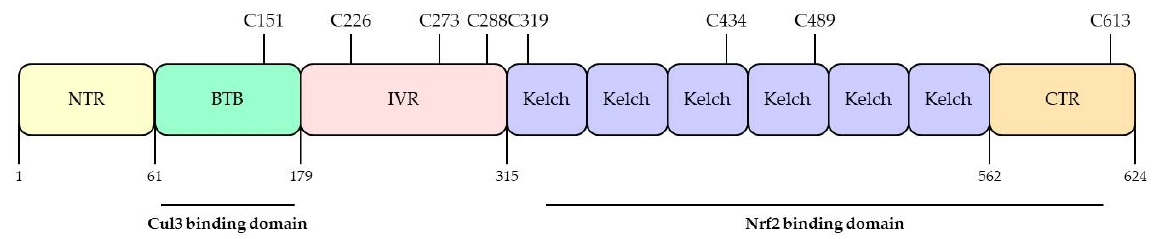
Figure 4. Domain structures and functional domains of KEAP1. The Keap1 protein contains Broad complex/Tramtrack/Bric- a-brac (BTB) domain, the intervening region (IVR) domain, and the Kelch domain. The BTB domain binds to Cul3 and forms homologs and dimers. The IVR domain contains C226, C273, and C288, which regulate Nrf2 activity. The Kelch domain has 6 conserved Kelch repeat sequences in the C-terminal domain, which also interact with the Nrf2. Adapted from Ooi et al. [57]. NTR; N-terminal, CTR; C-terminal, Cul3;